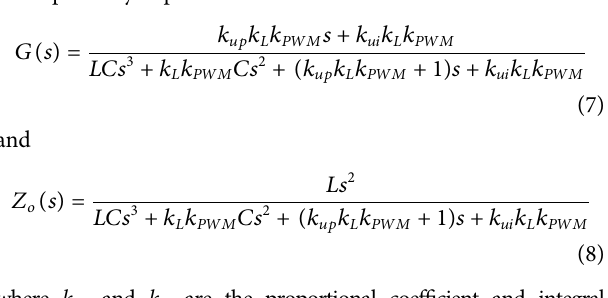
Frontiers in Energy Research |